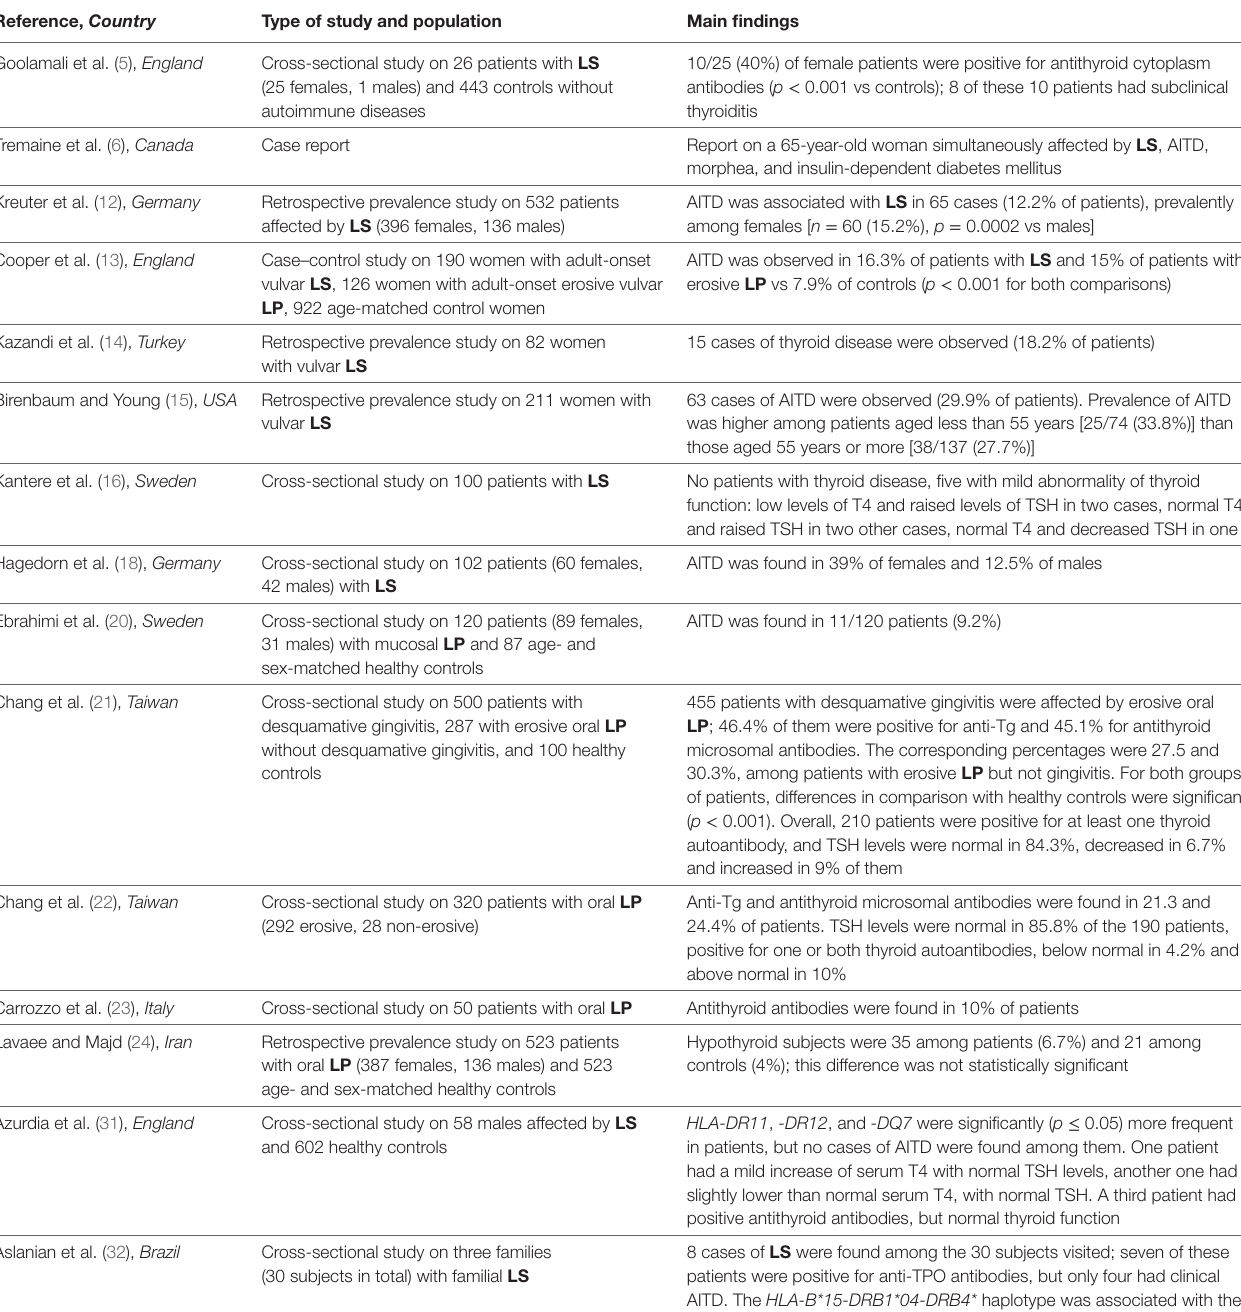
TAbLe 1 | Studies reporting clinical and/or laboratory data about subjects affected by lichen who were found positive for